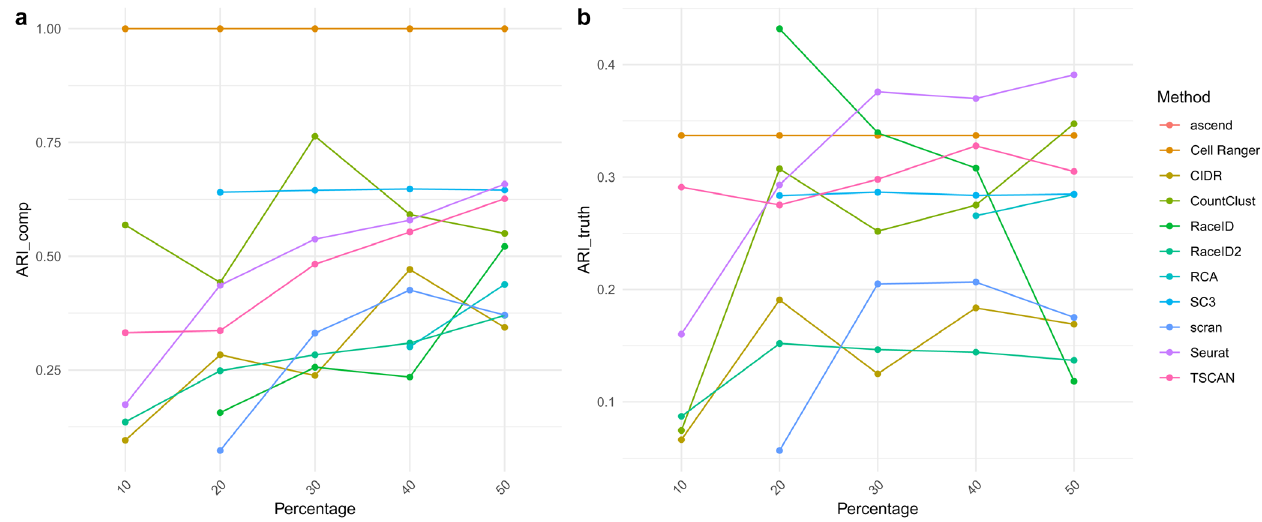
Figure 6. ( a ) ARI_comp of clustering solutions on Dataset 4 using 10%, 20%, 30%, 40% and 50% of the most expressed genes with respect to clustering Dataset 4 with all genes with the same method. ( b ) ARI_truth of clustering solutions on Dataset 4 using 10%, 20%, 30%, 40% and 50% of the most expressed genes. Note that many methods could not cluster the data when few genes were available. In particular, ascend did not run.